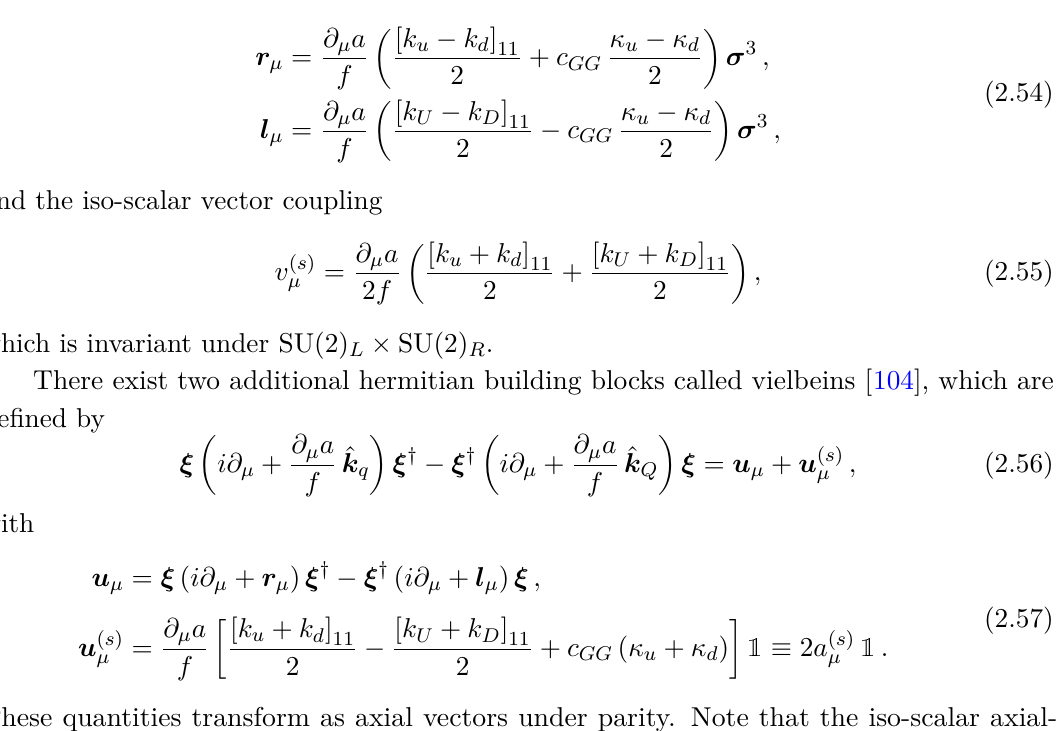
ˆ ) are diagonal matrices containing , k U D